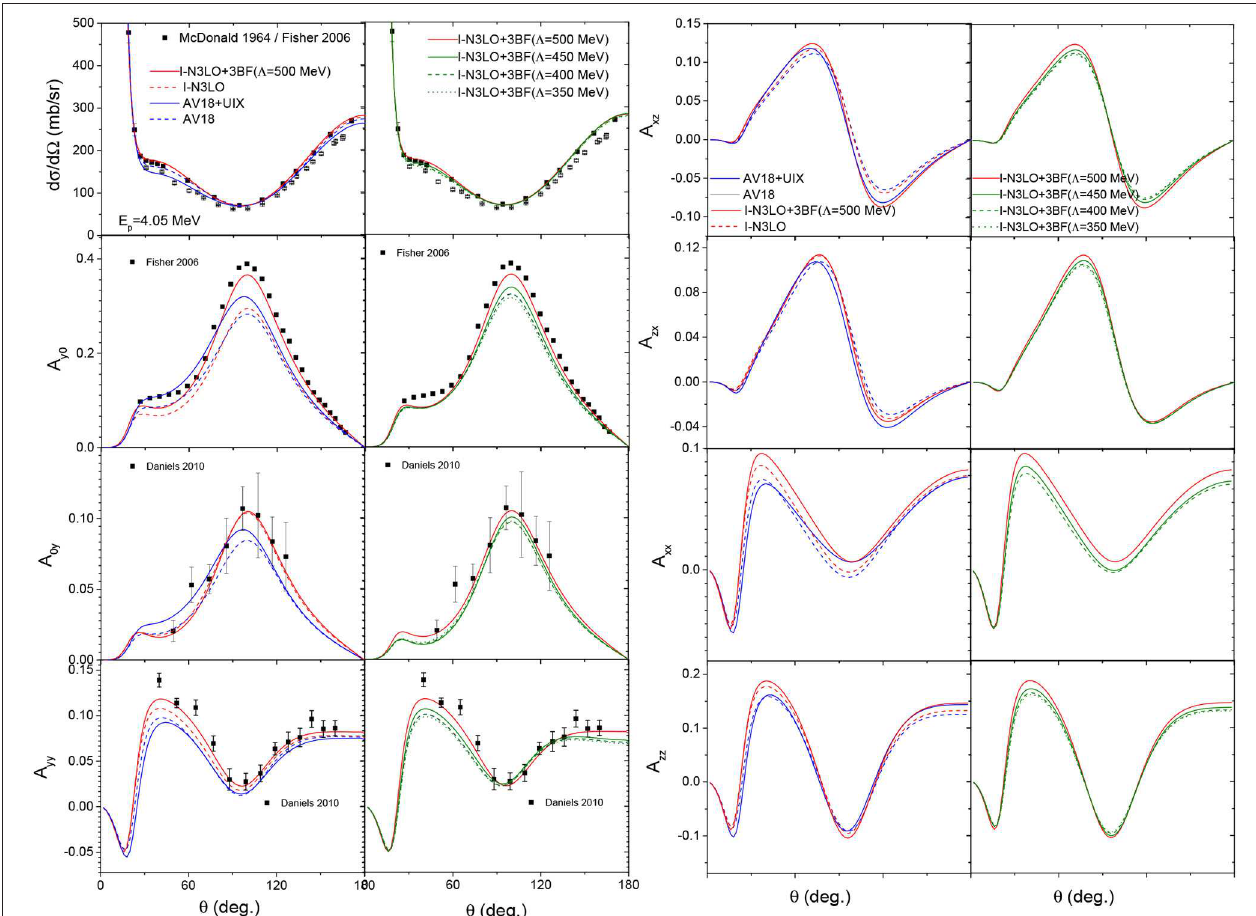
FIGURE 5 | Several differential observables calculated for proton scattering on 3 He at 4.05